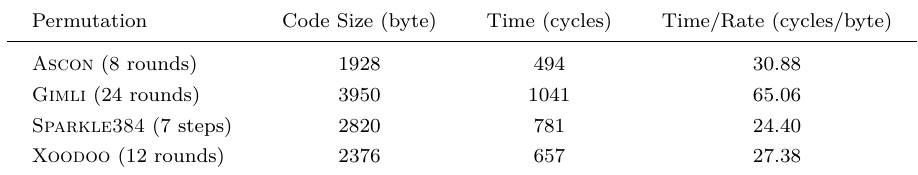
Table 12: Comparison of fully unrolled ARMv7-M Assembler implementations of the per- mutations of Ascon , Sparkle384 , Gimli and Xoodoo on a Cortex-M3 microcontroller.